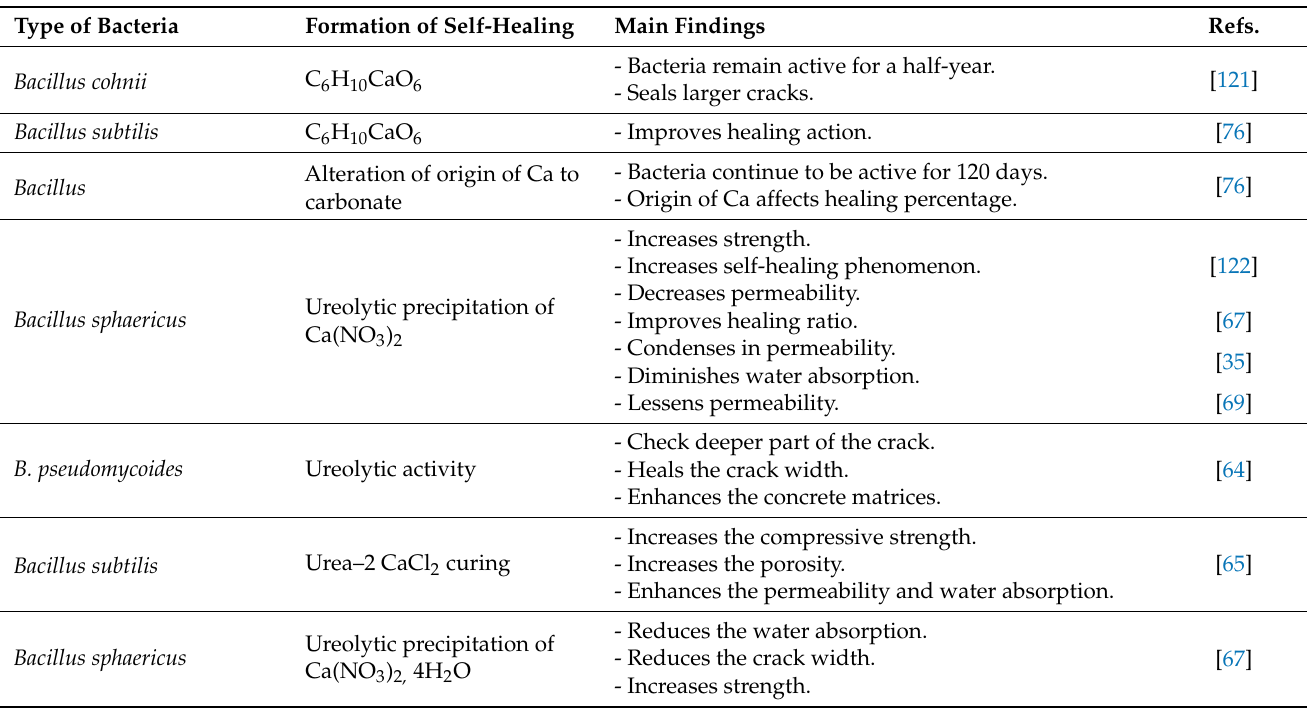
Figure 8. Schematic diagram illustrating the proposed healing mechanism: ( a ) in the event of cracking and water ingress; ( b ) the bacteria-based beads incorporated in the composite will swell, this swelling will clog the cracks, and concomitantly “free up” the bacteria, yeast extract and magnesium acetate contained in the beads; ( c ) the magnesium will precipitate as magnesium-based minerals, the spores will germinate as a result of being exposed to the solubilized yeast extract, and metabolize the acetate, inducing calcium-based mineral precipitation in and on the surface of the beads, healing the crack. (Adapted with permission from MDPI [161]). Table 4. Some of the bacteria encapsulated for